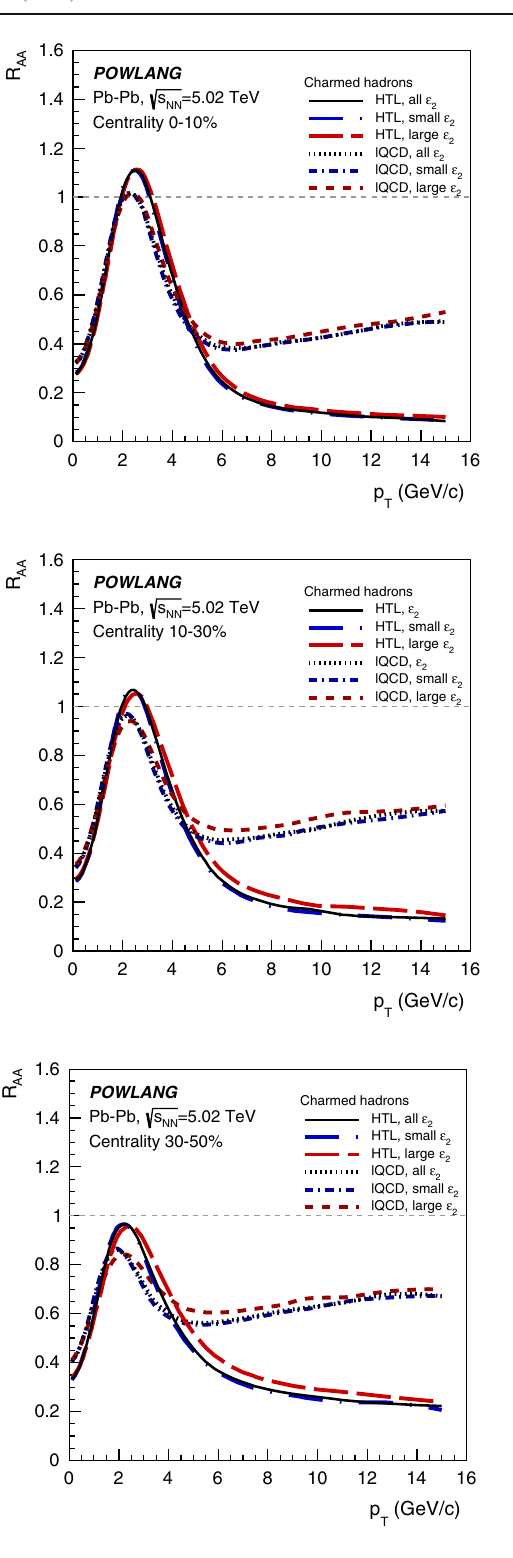
and the 60% lowest- (cid:7) 2 selection of events are compared to the unbiased case. For both choices of transport coefficients the results display